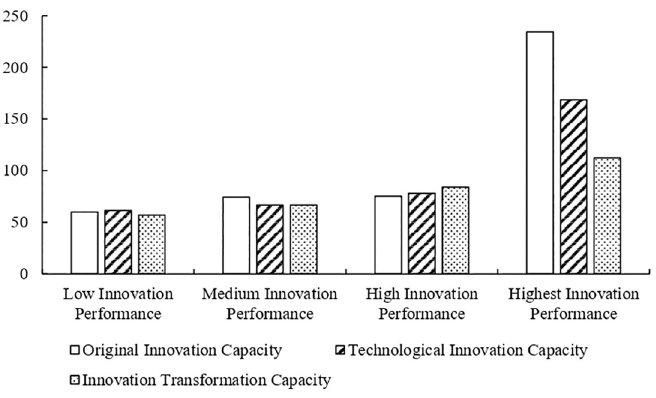
Fig 3. Three capabilities mean of UICs at different levels of innovation performance. Source: The authors.